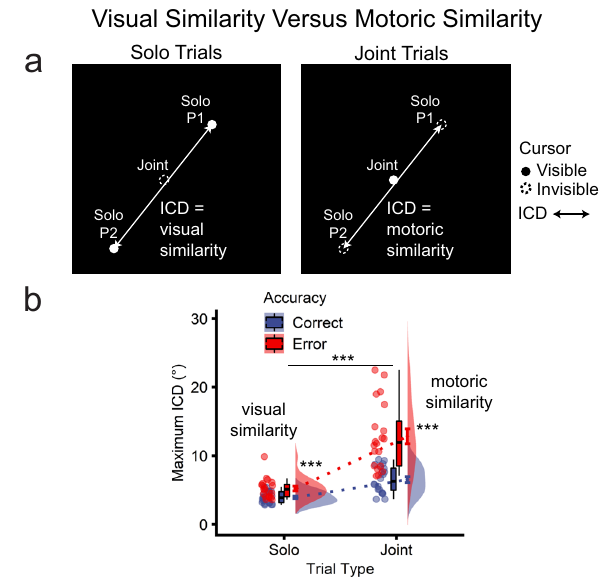
Fig. 10 Comparison of motoric similarity and visual similarity as explanatory factors for the correspondence between behavioural performance and interpersonal neural coupling ( n = 20 pairs). a Depiction of maximum inter-cursor distance (ICD) between visible solo cursors on solo trials (re fl ecting visual similarity between co-actors) and invisible solo cursors on joint trials (re fl ecting motor similarity). b Effects of control and accuracy on